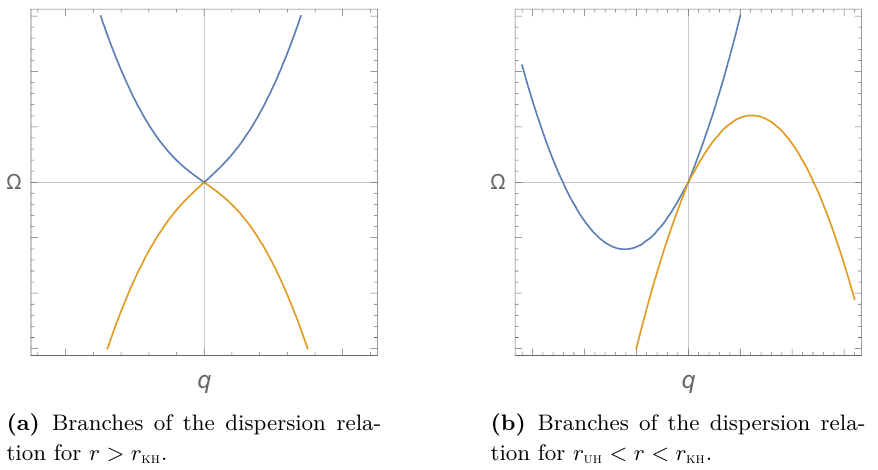
Figure 2. Schematic solution to the dispersion relation for different values of the radius. The colors distinguish the two branches in ω . The blue (orange) line corresponds to the ω > 0 ( ω < 0 ) branch. For radii larger outside the Killing horizon, there are only two solutions for positive Killing frequency Ω . For radii in the region between the Universal and Killing horizons, the parabolas deform and we find four possible modes with positive Ω . Two of them remain close to | q | ∼ O (1) while the other two exhibit momenta comparable to the UV scale | q | ∼ Λ